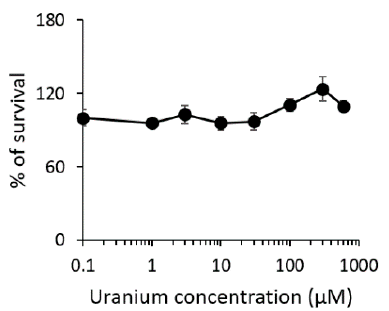
Figure 2. Uranium cytotoxicity in S3